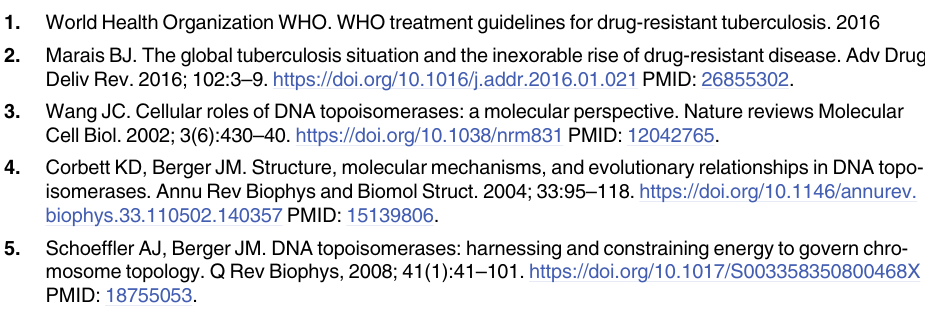
S1 Fig. Effect of FP-11g resistant mutations on M. smegmatis growth and colony morphol- ogy. S1 Table. Summary of mutations associated with FP-11g resistance in M. smegmatis .